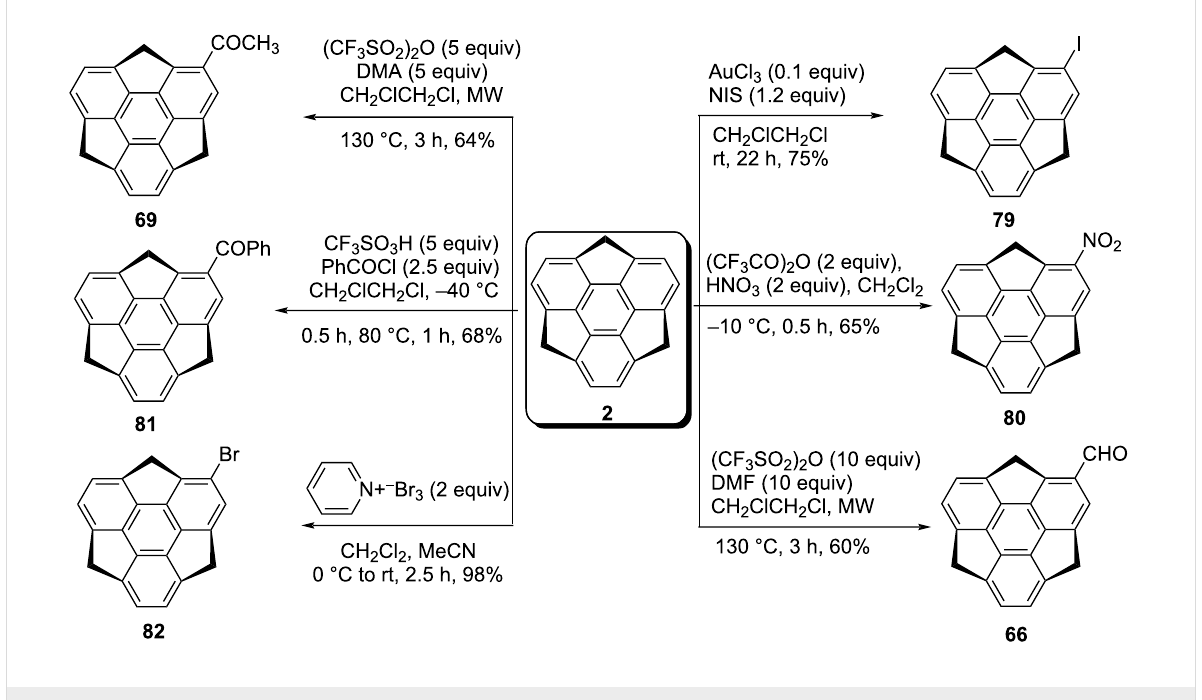
Scheme 18: Synthesis of diverse monosubstituted sumanene